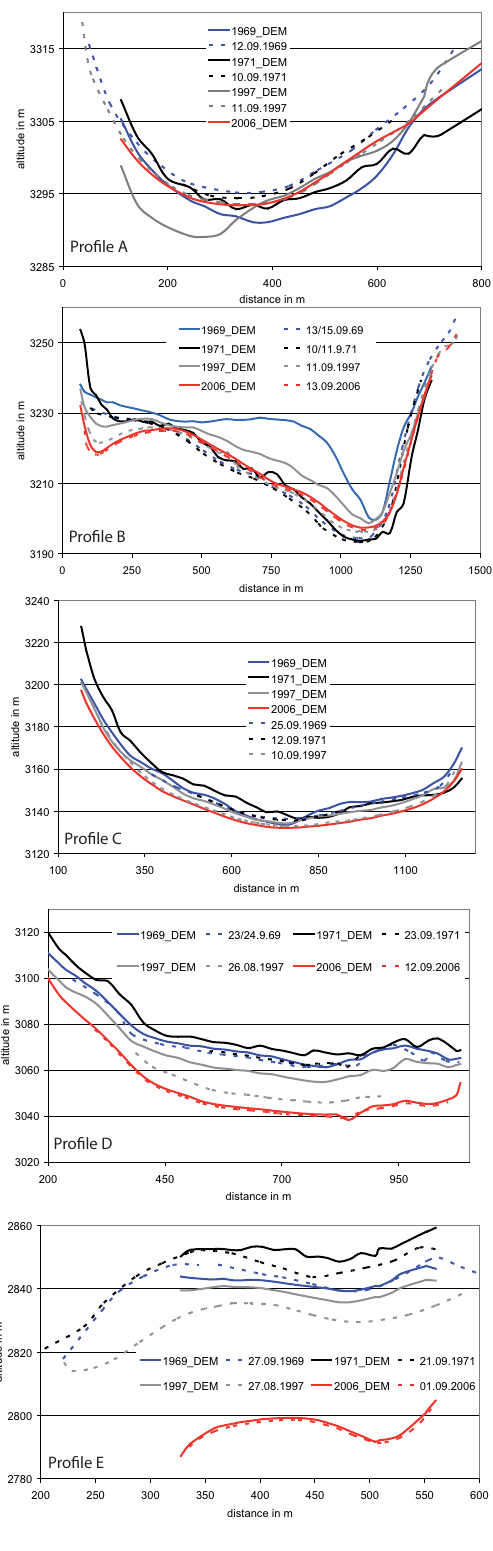
Fig. 10. Comparison between the elevation measured in the field along the profiles A to E at Kesselwandferner with the elevation in the DEMs of the specific